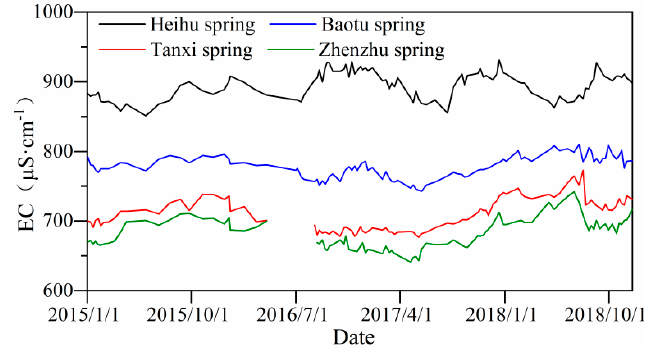
Figure 3. Dynamic chart of the electrical conductivity (EC) of spring water.